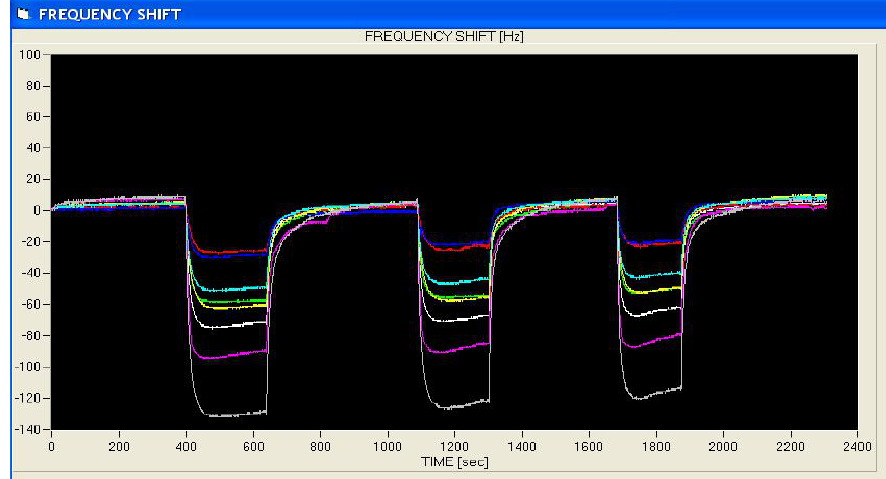
Figure 2. LibraNose 2.1 e-nose sensor-array output derived from Ganoderma lucidum- decayed Celtis australis wood block one year after artificial inoculation. Three replication analyses were performed per sample during a 2,400 s run cycle. Notice that there is a complete reversal of sorption of volatiles to the sensors as indicated by frequency shifts at three separate instances during the